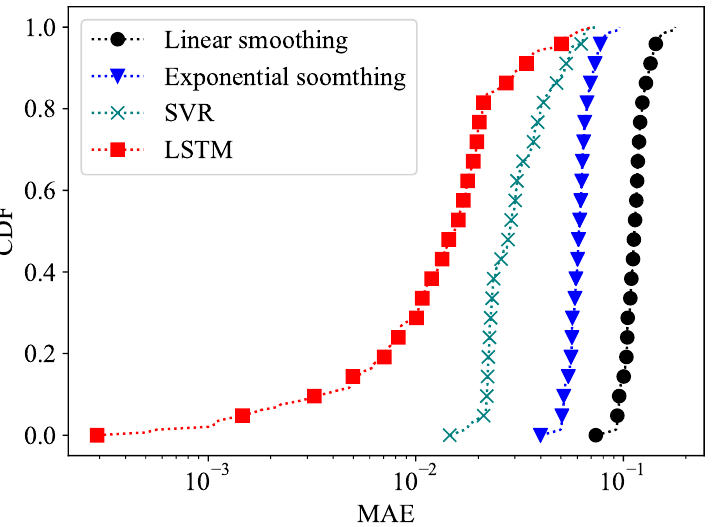
Figure 5. CDF of MAE for different methods in estimation model to predict SNR in different